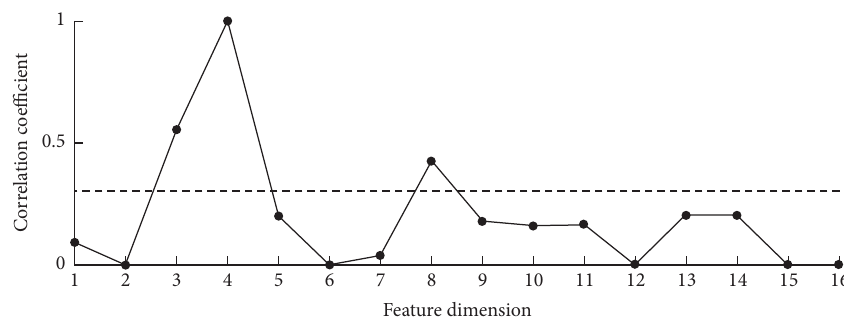
Figure 8: Correlation between P 2 and other features. Table 4: KPCA and RUL values of some samples during the degradation process.